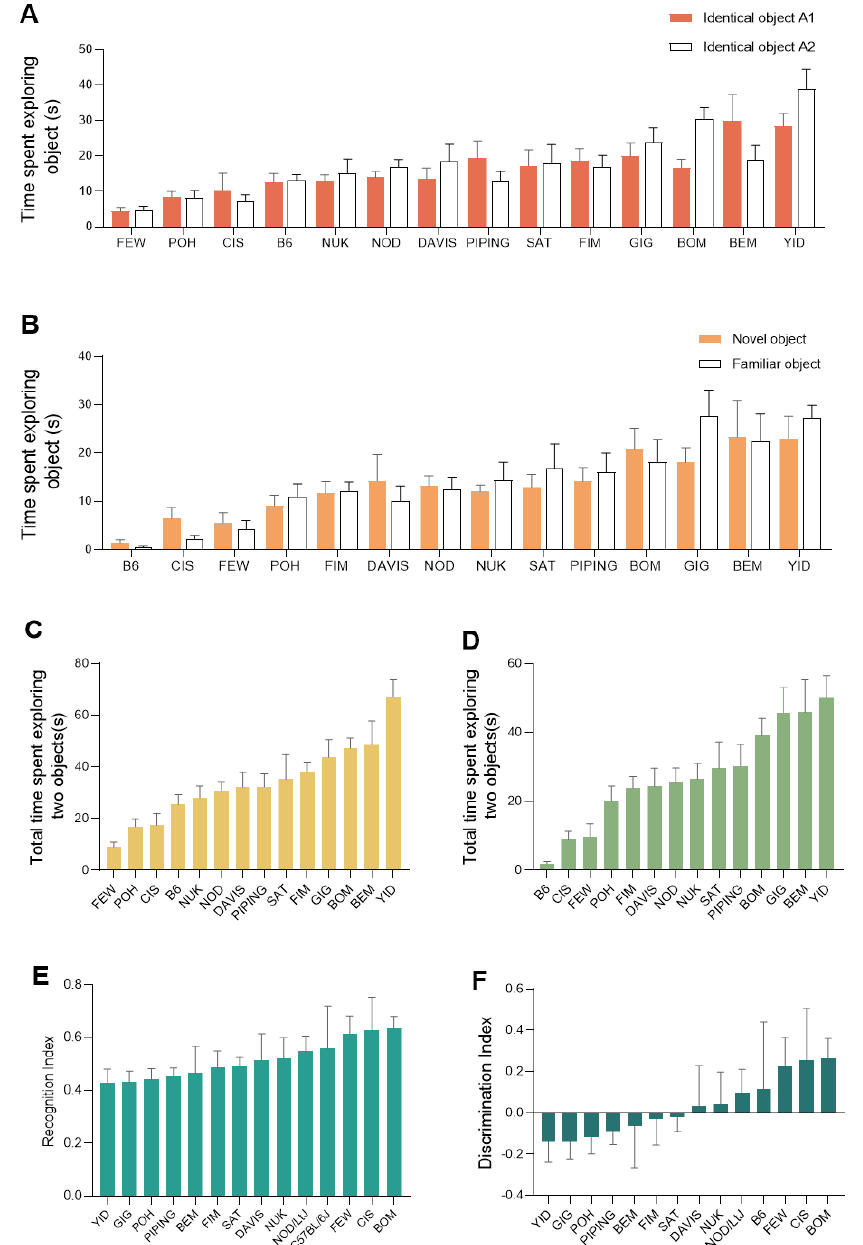
Figure 3. Phenotypic diversity in novel object recognition test traits among the CC population. ( A ) exploration time in the training phase (s). ( B ) Exploration time in the testing phase (s). ( C ) Total time spent exploring two objects in the training phase (s). ( D ) Total time exploring two objects in the testing phase (s). ( E ) recognition index. ( F ) Discrimination index. Plots are expressed as mean ± SEM, with CC lines ordered along the x -axis by mean per phenotype. (( A , B ) Two-way repeated measures (mixed model) ANOVA test. ( A ) object x group interaction effect: p = 0.113, object: p = 0.234, group: p < 0.001; ( B ) object x group interaction effect: p = 0.540, object: p = 0.557, group: p < 0.001. ( C − F ) one-way ANOVA p < 0.001, p < 0.001, p = 0.249, and p = 0.249).